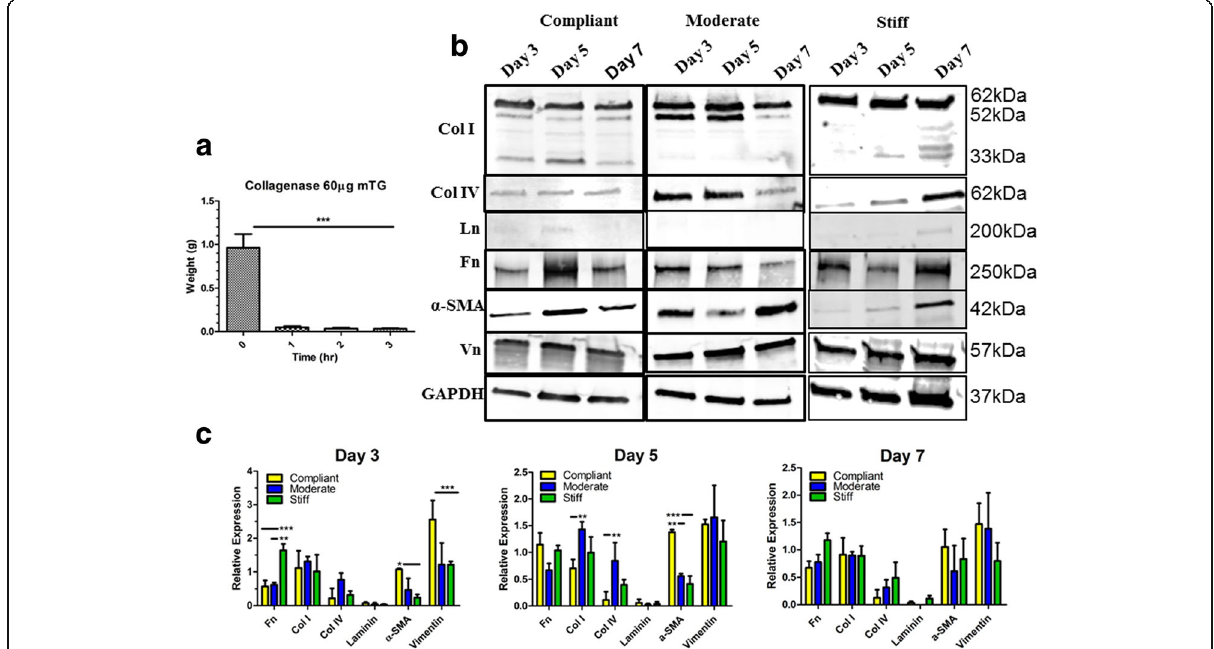
Fig. 6 HMF expression of myofibroblast markers and ECM proteins in mTG hydrogels HMFs were isolated from mTG cross-linked hydrogels and analyzed for expression of myofibroblast markers and ECM proteins. a Collagenase was used to isolate HMFs from stiff (e.g. 60 μ g/ml) mTG hydrogels. Changes in the weight of the hydrogel were monitored during the incubation period wherein 1 h was shown to be a sufficient length of time for dissolution of the hydrogel. b Protein lysates from compliant, moderate and stiff hydrogels were subjected to western blot for analysis of myofibroblast and ECM proteins. α -SMA was most highly expressed in compliant hydrogels at day 5 and for moderate and stiff hydrogels at day 7. Collagen I and vimentin expression were upregulated in HMF in moderate and stiff hydrogels in comparison to HMFs in compliant hydrogels. Collagen IV was more abundant in HMFs encapsulated in the moderate and stiff hydrogels with expression greatest at days 3 and 5 for moderate and day 7 for stiff hydrogels. Fibronectin expression was highest overall at days 5 and 7 for HMFs in compliant and stiff hydrogels, respectively. Laminin was detectable, albeit negligibly, at days 5 and 7 for HMFs in compliant and stiff hydrogels, respectively. c Fibronectin expression was increased for stiff hydrogels at days 3 (significantly) and day 7 for compliant hydrogels. Collagen I was increased for moderate hydrogels at days 3 and 5 (significantly) and was similarly expressed for all hydrogel conditions at day 7. Collagen IV was increased for moderate hydrogels at days 3 and 5 (significantly) and for stiff hydrogels at day 7. Laminin was negligibly expressed. α -SMA was consistently increased for compliant hydrogels at each time point assessed. Vimentin was significantly increased at day 3 for compliant